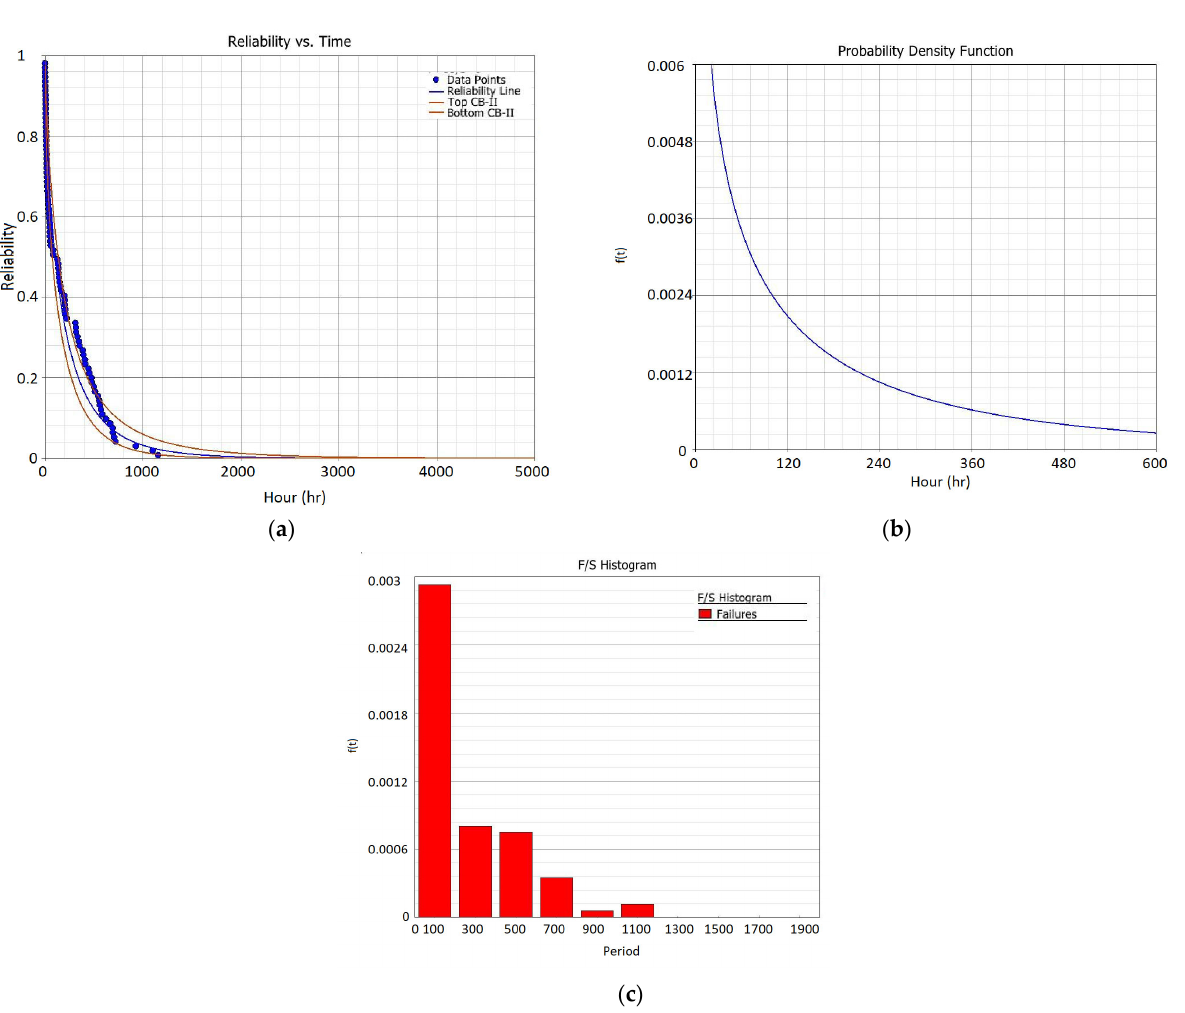
Figure 7. ( a ) Reliability function, ( b ) probability density function, ( c ) histogram for Unit 2.